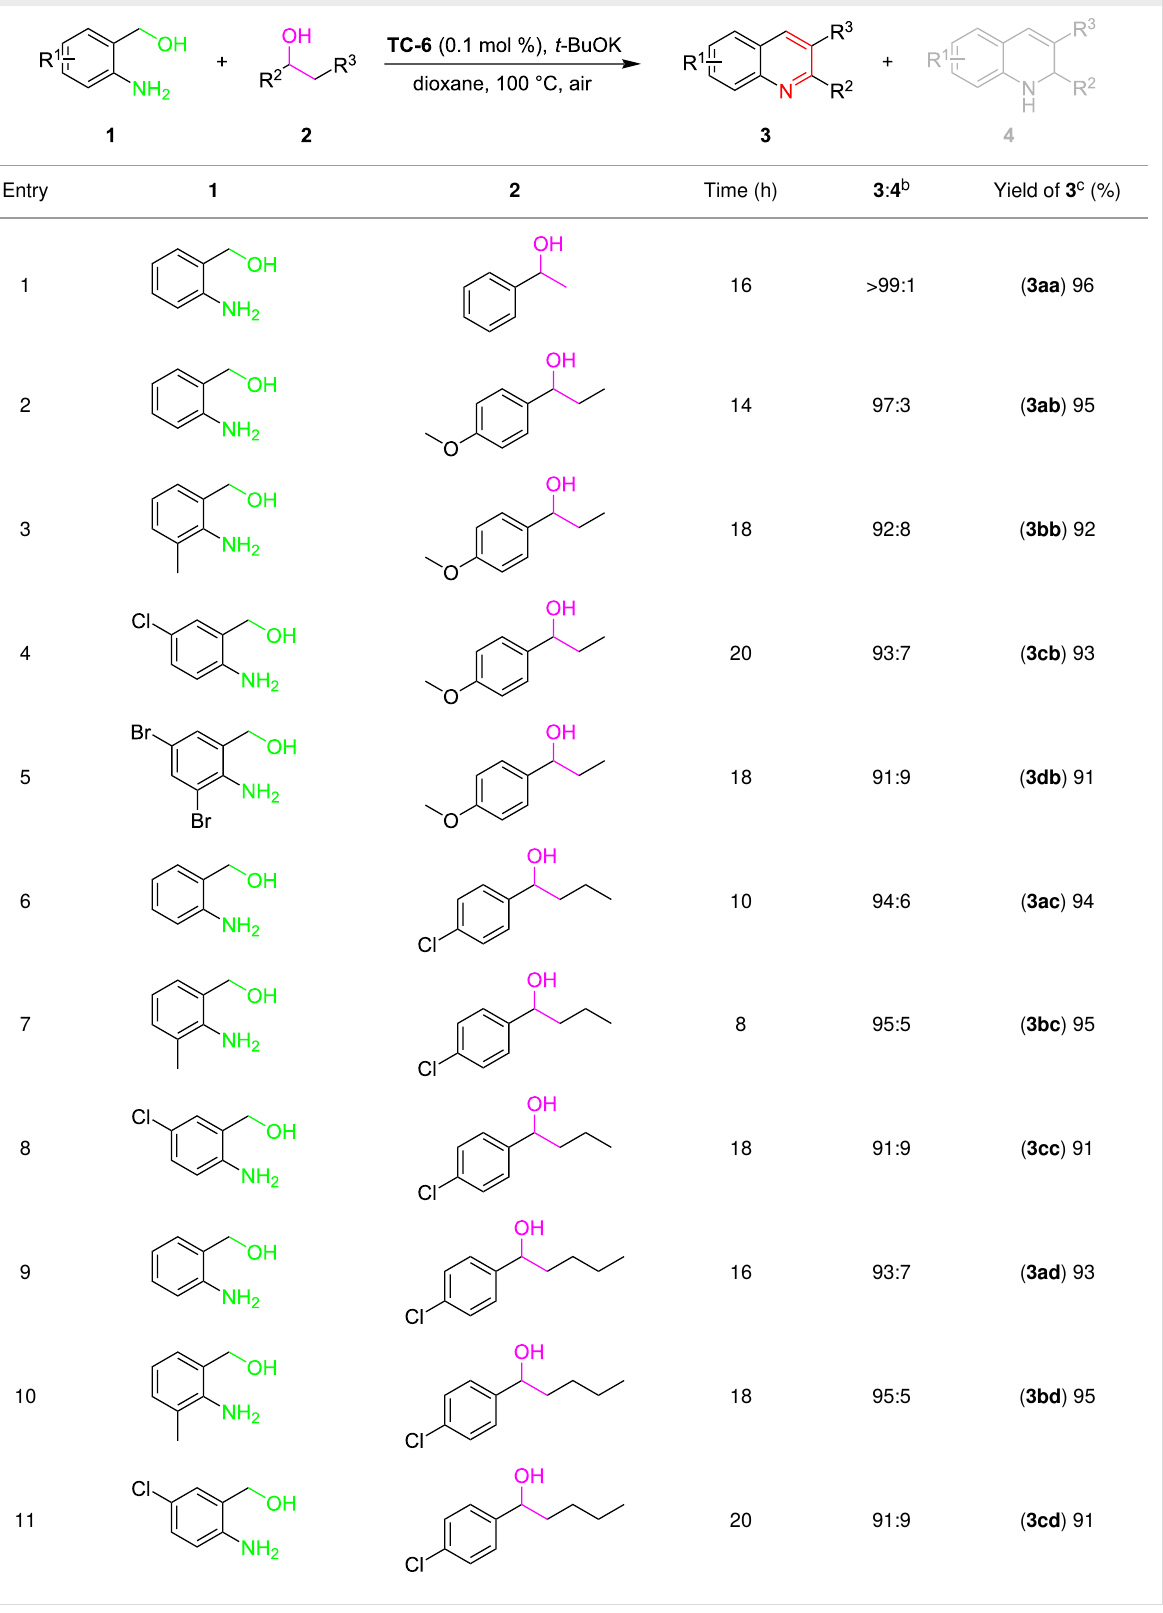
Table 3: Cyclometalated iridium-catalyzed ADC reaction of various 2-aminobenzyl alcohols and secondary alcohols.